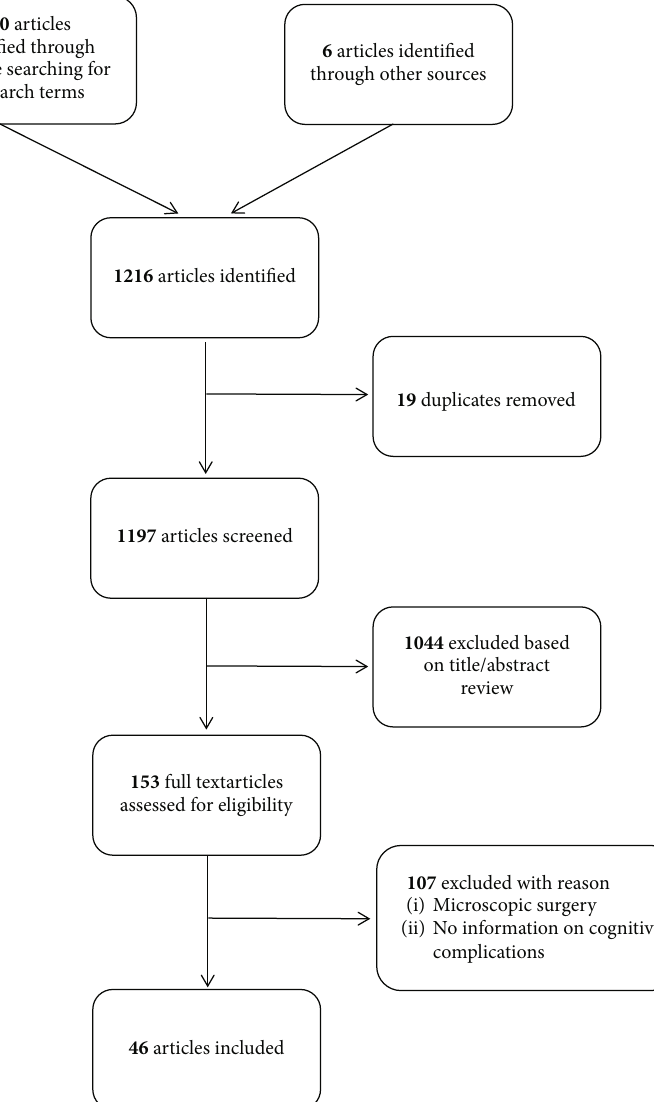
Figure 1: Selection of articles included in this